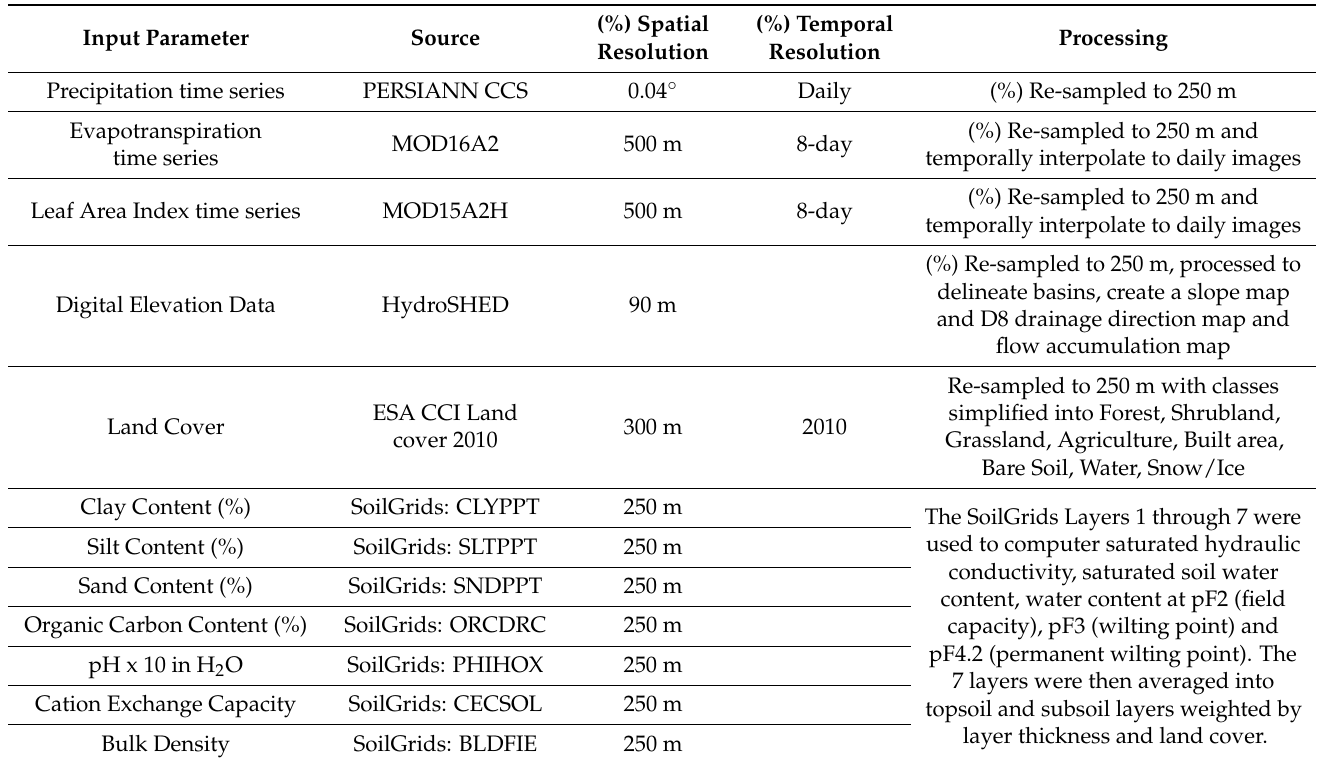
Table 2. Input data to the modified SPHY model used to simulate the differences in hydrology for forest cover ranging from 2% to 75% in the Central Indian